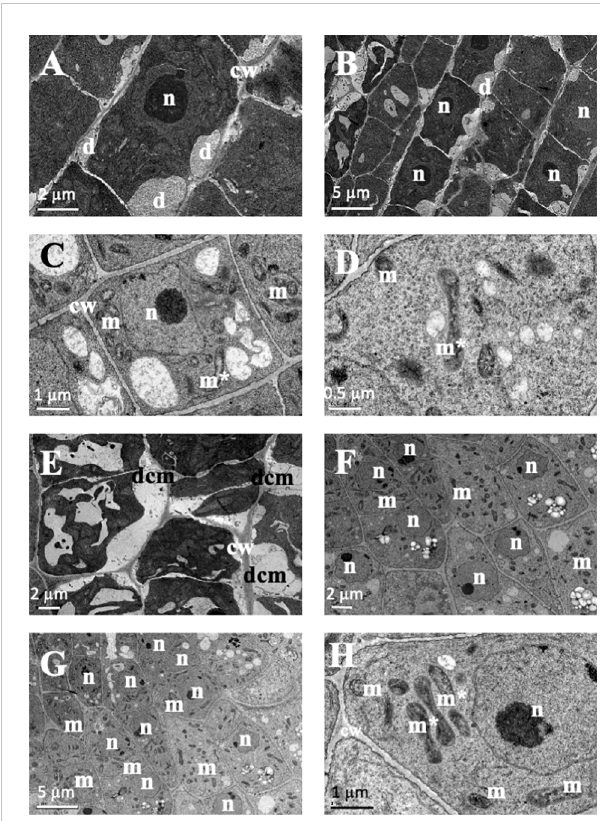
FIGURE 3 Images of transmission electron microscopy (TEM) of Arabidopsis thaliana roots treated with IC 50 of TC for 7 days. (A, B) Cells with deposits between the membrane and wall. (C, D, H) Cells with dividing mitochondria. (E) Cell with a plasma membrane separated from the cell wall. (F, G) Cells with many mitochondria. (n, nucleus; m, mitochondria; cw, cell wall; dcm, detached cell membrane; m*, dividing mitochondria). Scale bars: (A, E, F) 2 µm; (B, G) 5 µm; (C, H) 1 µm; D 0.5